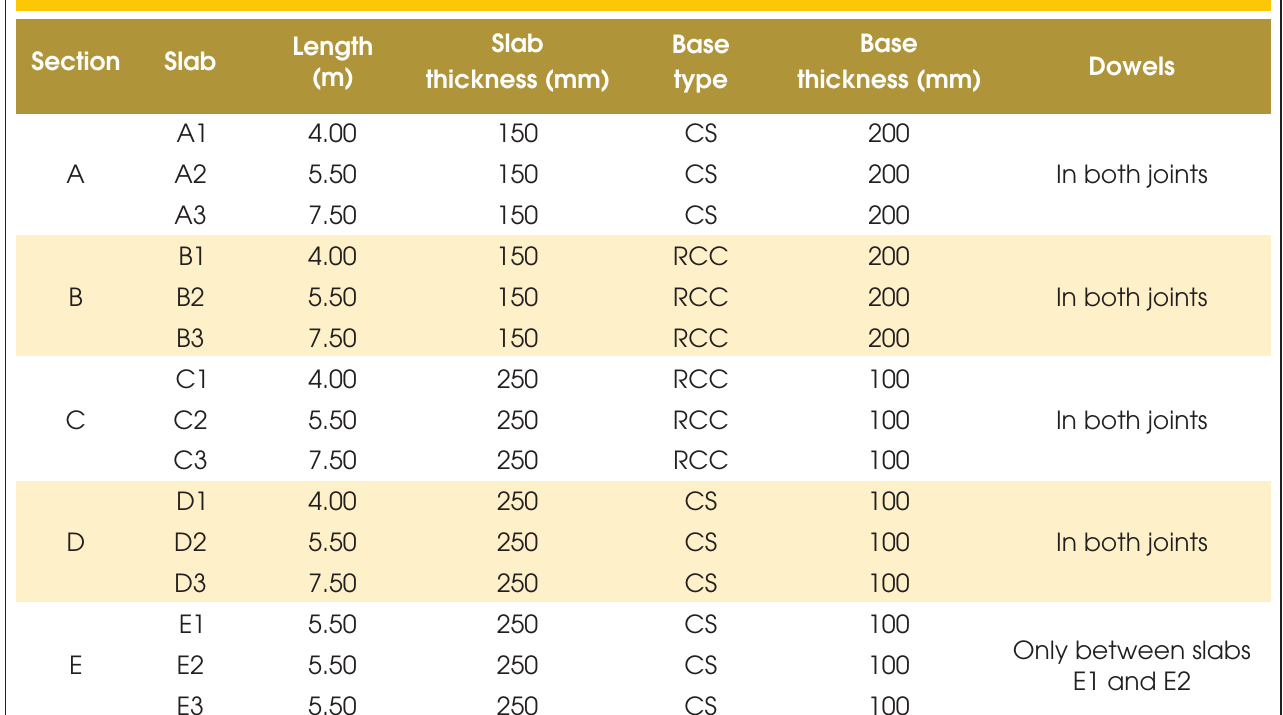
Table 1 – Experimental plain concrete pavement sections at USP